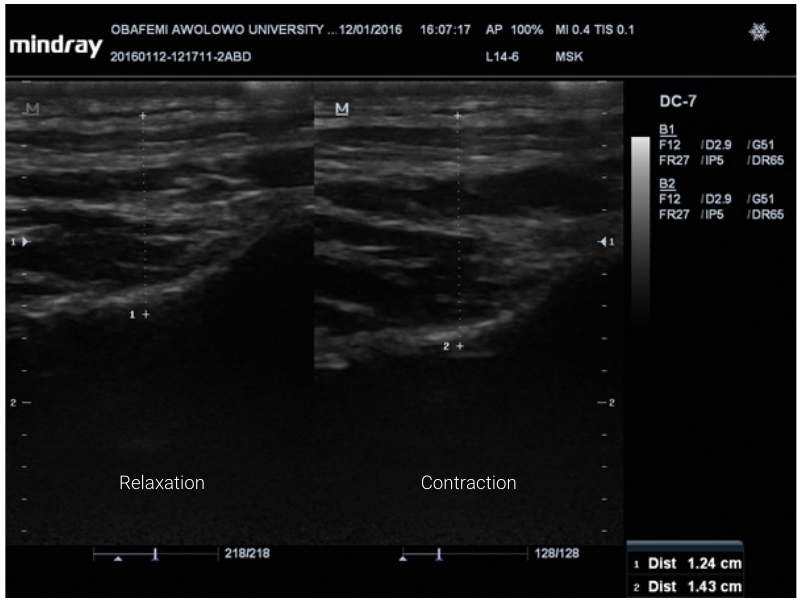
Figure 1. Ultrasonographic image of relaxed and contracted masseter muscle. The callipers indicate the points at which the muscle thickness was taken. The superficial cursor indicates the surface of the transducer, while the deep cursor indicates the mandibular